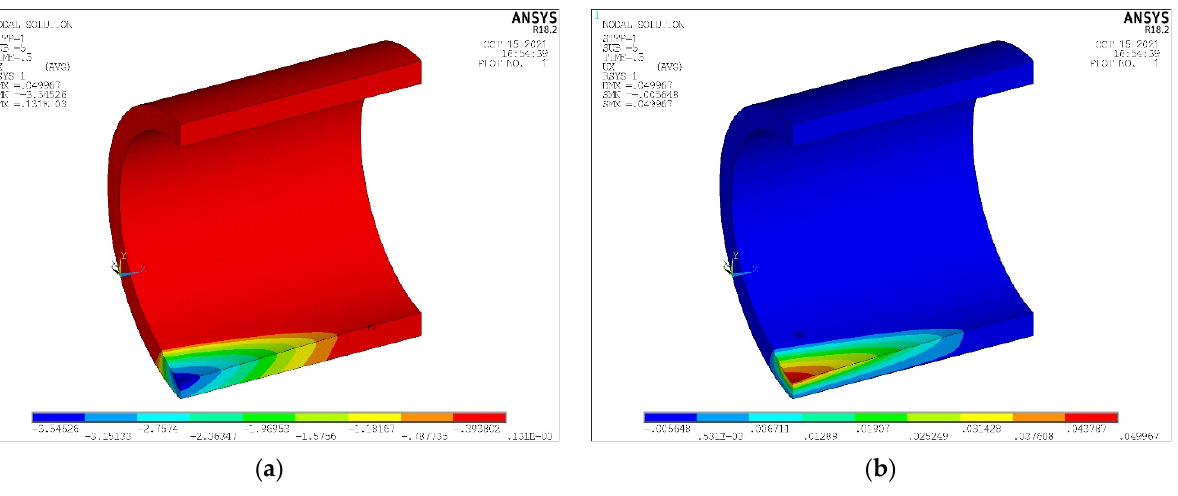
Figure 9. FEM results for straight shaft when Φ = 0.02° and δ max = 0.05 mm: ( a ) result of contact pressure; ( b ) result of radial displacement.